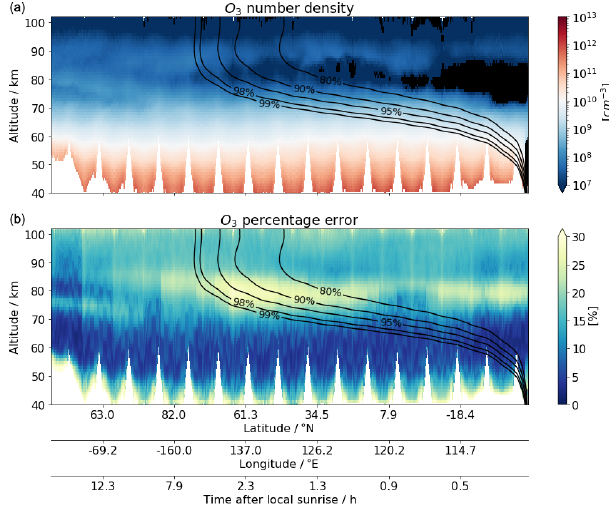
Figure 7. A simple estimation of ozone number density (a) and its random error relative to the individual a priori profiles (b) , assum- ing all collected measurements of O 2 (a 1 (cid:49) g ) are in equilibrium state for one orbit collected on 30 March 2008 from 22:21:09 to 23:09:13 (orbit number 38720). Superimposed are the contour lines of equilibrium index (see text) corresponding to 80%, 90%, 95%, 98% and 99% of the equilibrium level. Negative values are indi- cated in black. All results shown here have a measurement response greater than 0.8.